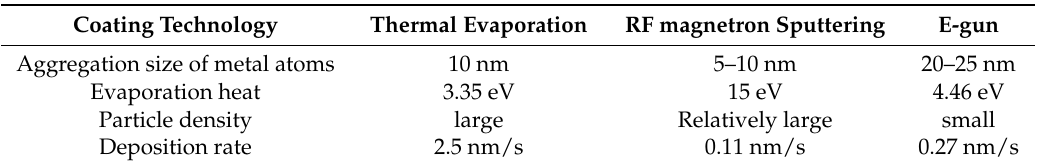
Table 1. Comparison of characteristic parameters of the deposited Au-Ag nanopariticle arrays by the methods of thermal evaporation, RF magnetron sputtering, and e-gun